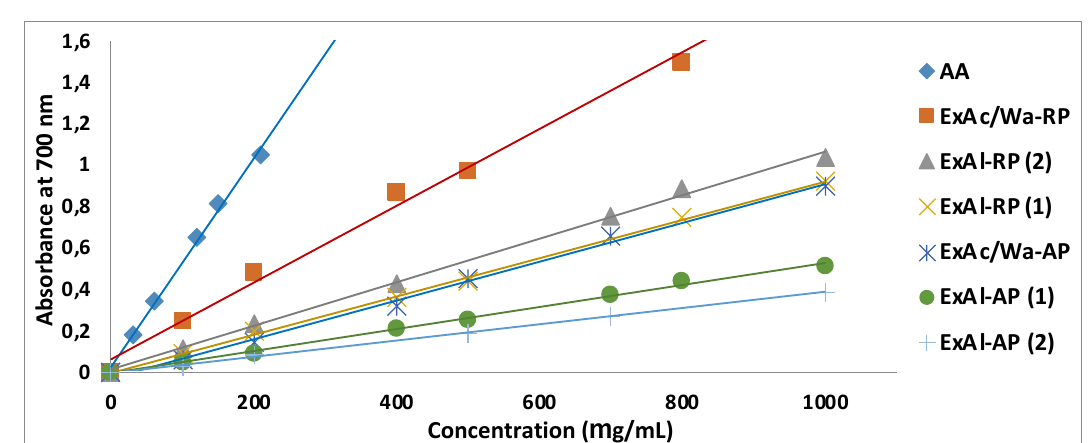
FIGURE 5 - Straight, expressing the variation of the absorbance as a function of the concentrations of Haloxylon Scoparium extracts, obtained by the FRAP